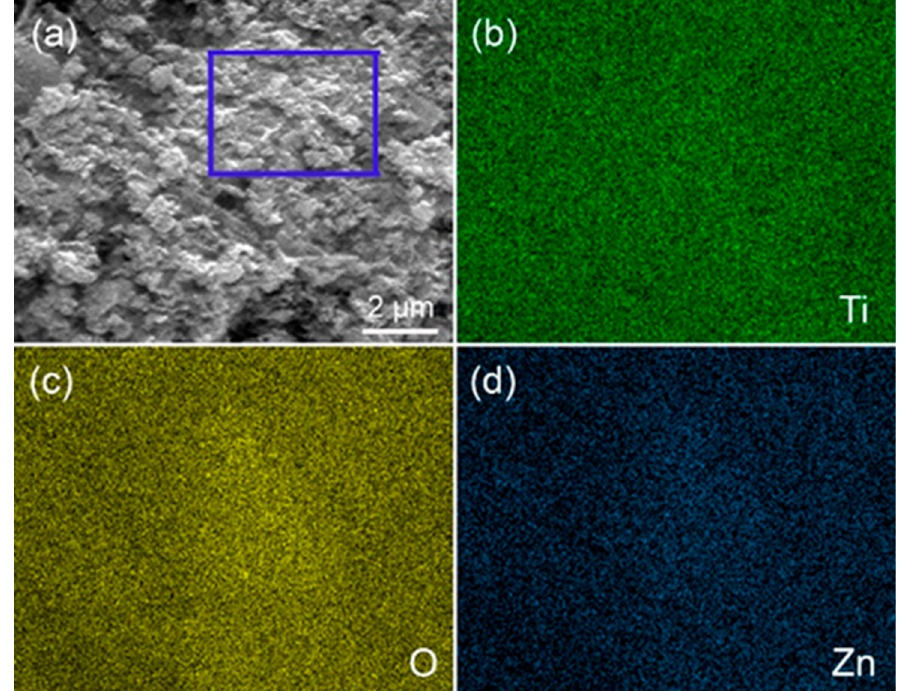
Figure 3. ( a ) The selected zone of for elemental mapping of TiO 2 -passivated ZnO HMS, ( b – d ) elemental mapping results of Ti, O, and Zn, respectively.